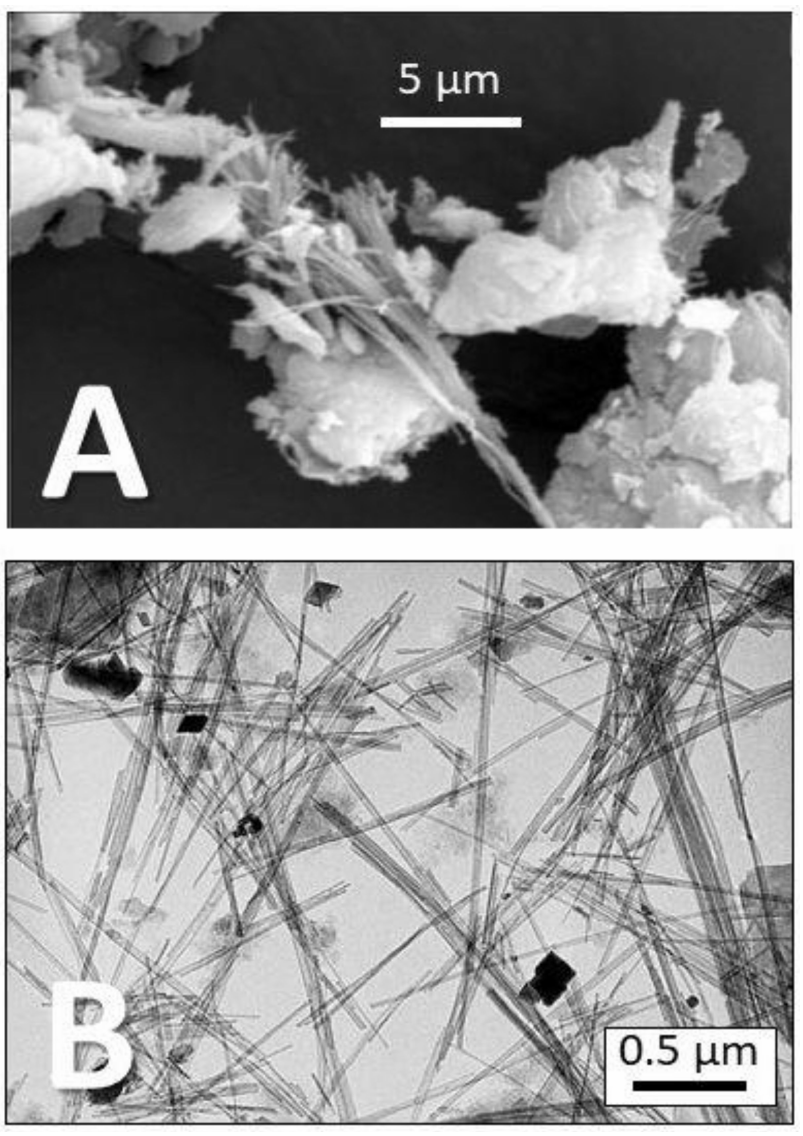
Figure 8. Interstitial clay minerals. ( A ) Back-scattered electron image of fibrous palygorskite from Langer Heinrich. Platy clay mineral not identified [21]. ( B ) TEM image of vermiculite, Langer Heinrich. Black phase unidentified